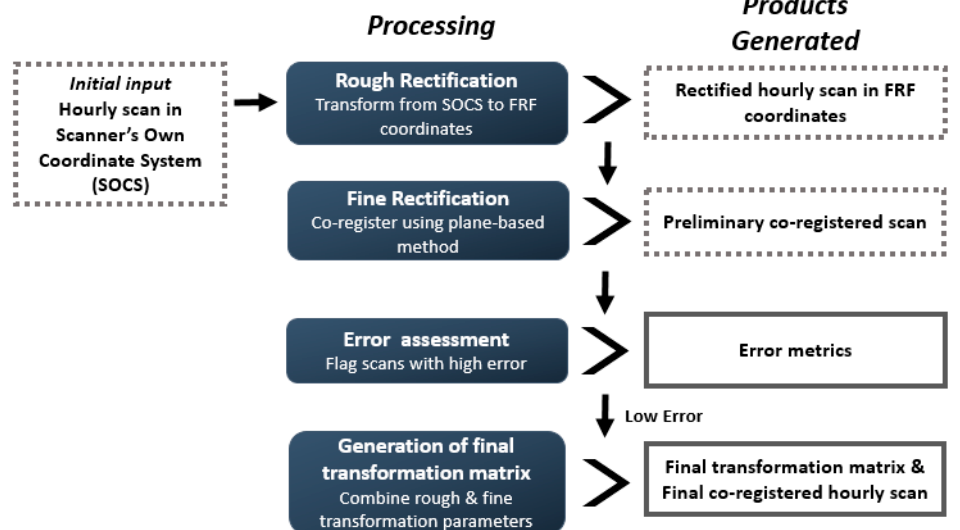
Figure 3. Flowchart of the co-registration process and products generated during each step. Products generated can be separated into intermediate products (in dotted boxes) and final products (in solid boxes).